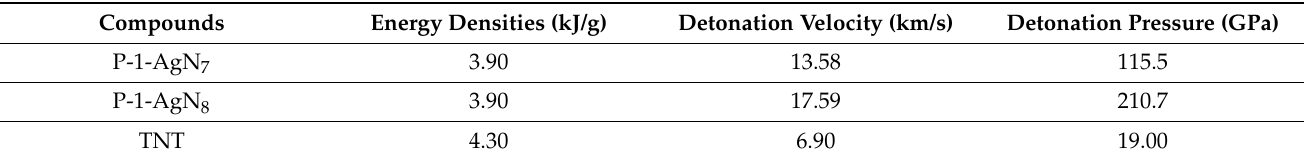
Table 3. The energy density and detonation properties of P-1-AgN 7 and P-1-AgN 8 compounds in comparison to